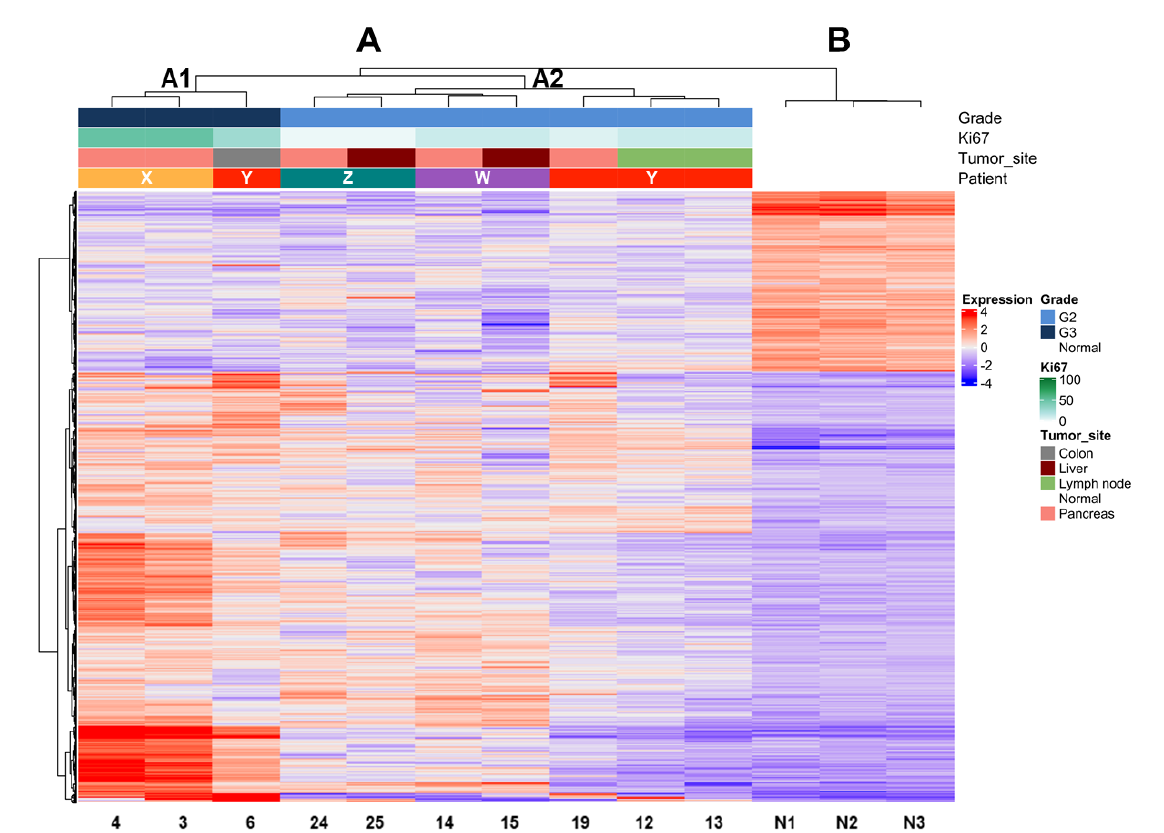
Figure 2. Unsupervised clustering of PanNET samples (primary and metastasis/recurrency) of four patients with multiple samples and three normal pancreases. Hierarchical clustering shows the segregation of samples according to their grade based on Ki67. estimation in the first step and to the belonging patient in the second. Major clusters are A (all PanNETs) and B (all normal tissues). Cluster A is further subdivided into subgroup A1 (all G3 samples) and subgroup A2 (all G2 samples). Samples from the same patient within clusters A1 and A2 are most similar to one another (smaller dendrogram distance).